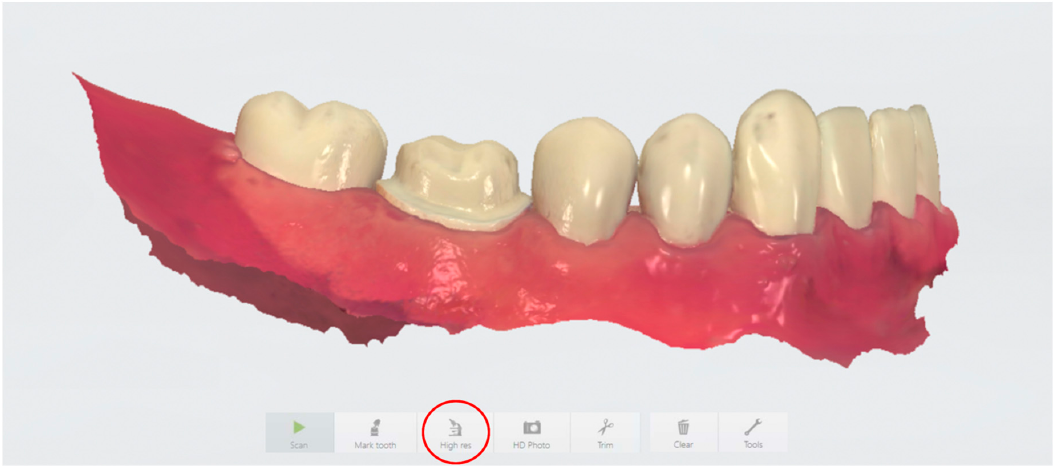
Figure 1. Depiction of the digital interface using the 3Shape TRIOS 3 scanner and software, highlighting the High Resolution (High res) feature.